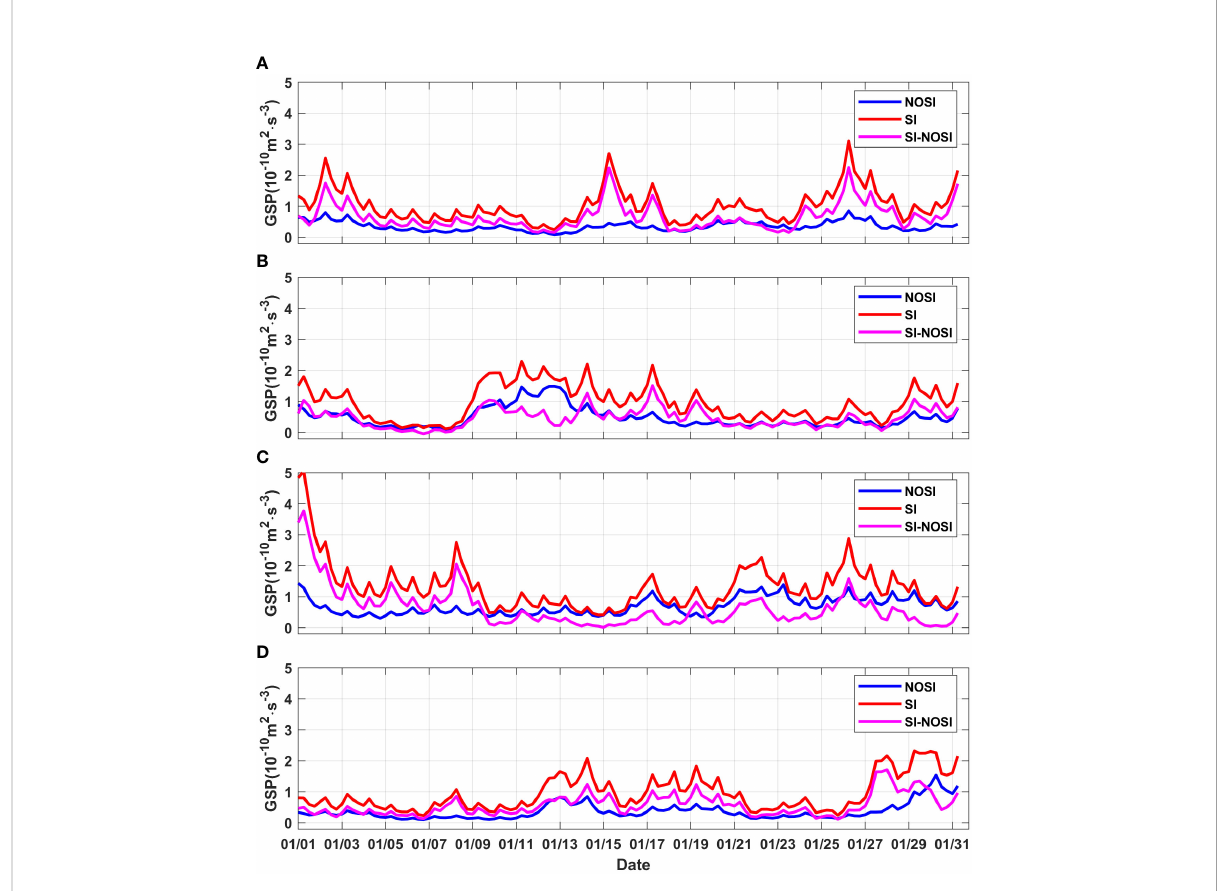
FIGURE 6 The time series of the GSP and GSP difference of two cases in the upper 50 m in January (A) 2017, (B) 2018, (C) 2019, (D) 2020. GSP, geostrophic shear production.